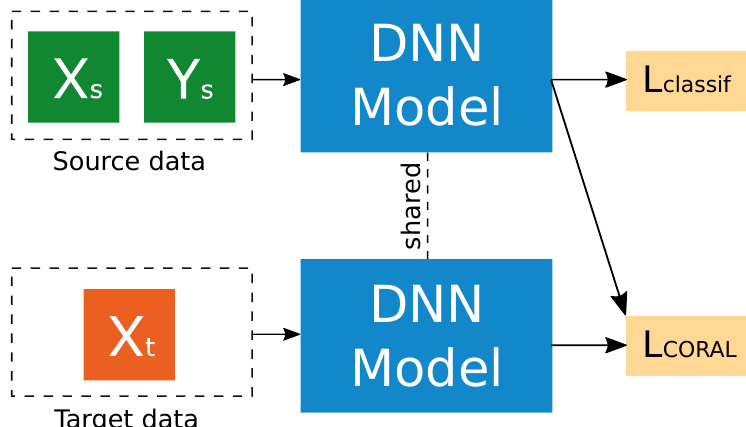
Figure 2. Schematic representation of Deep CORAL adaptation